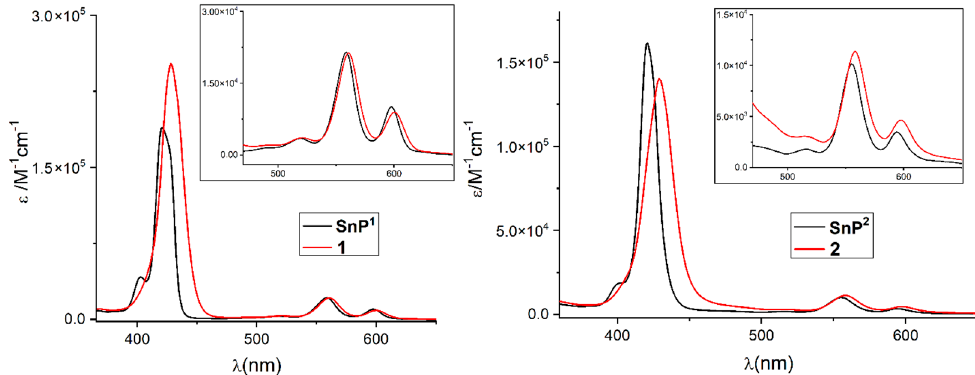
Figure 1. The UV–vis absorption spectra of SnP 1 , SnP 2 , 1 , and 2 in chloroform.